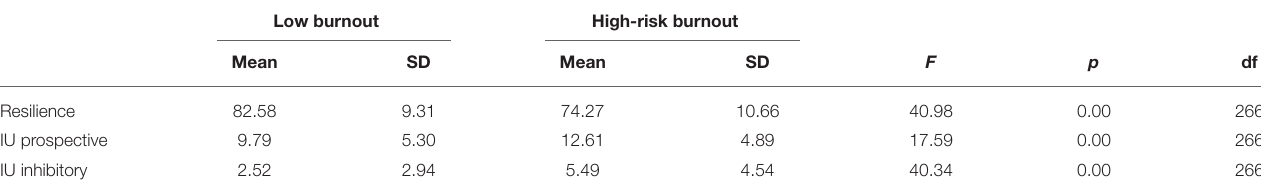
TABLE 5 | One-way ANOVAs between cluster profiles on resilience and intolerance of uncertainty.